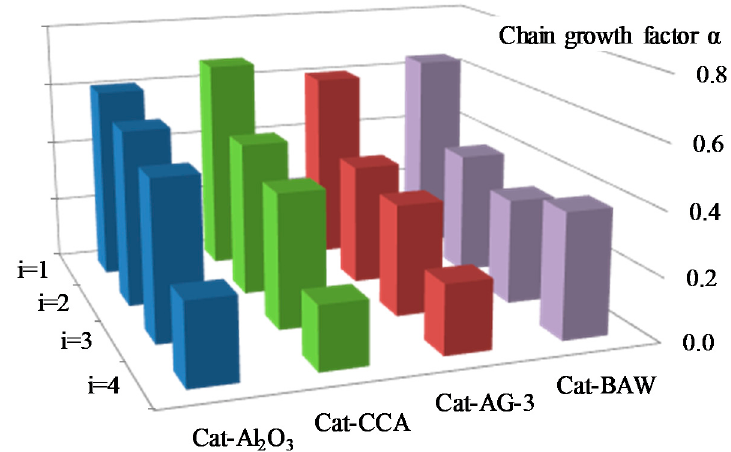
Figure 4. Chain growth factors α i at 360 °C for steps i = 1, 2, 3, 4 over the KCoMoS 2 catalysts supported on Al 2 O 3 , CCA, AG-3 and BAW.